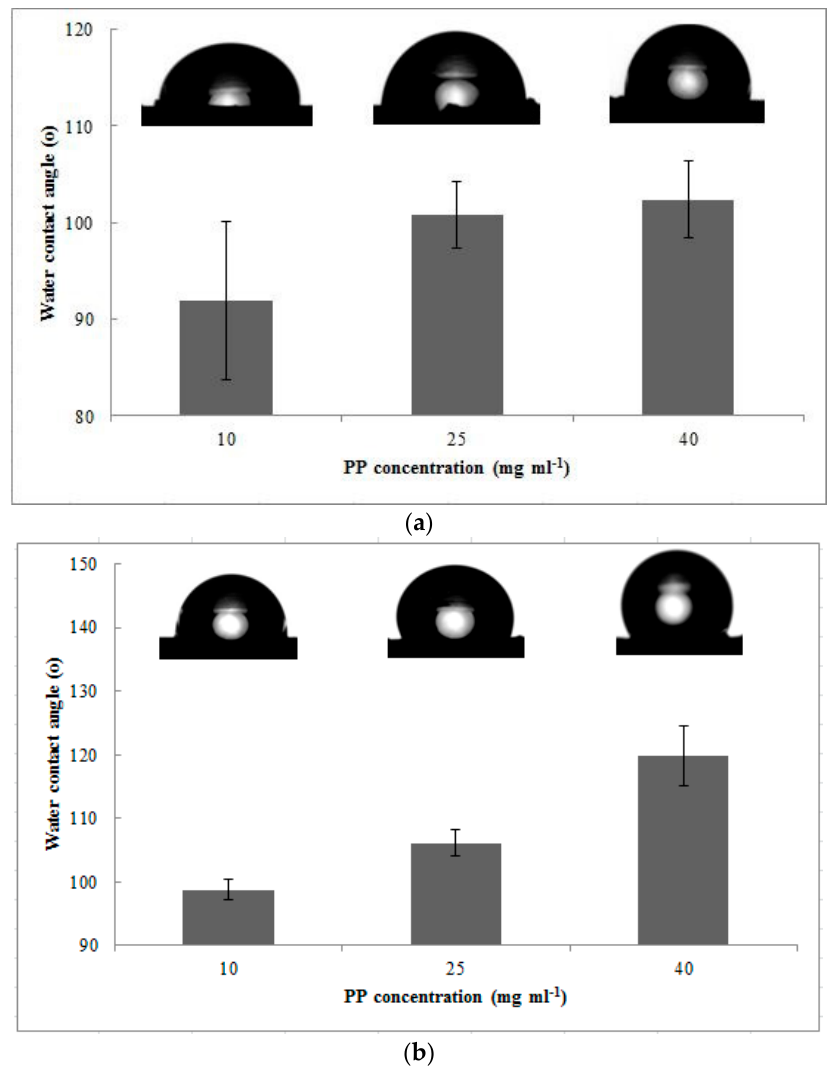
Figure 6. Contact angles of the modified PVDF hollow fiber membrane without MEK ( a ) and with MEK ( b ). The corresponding images of water droplets are depicted for each concentration.